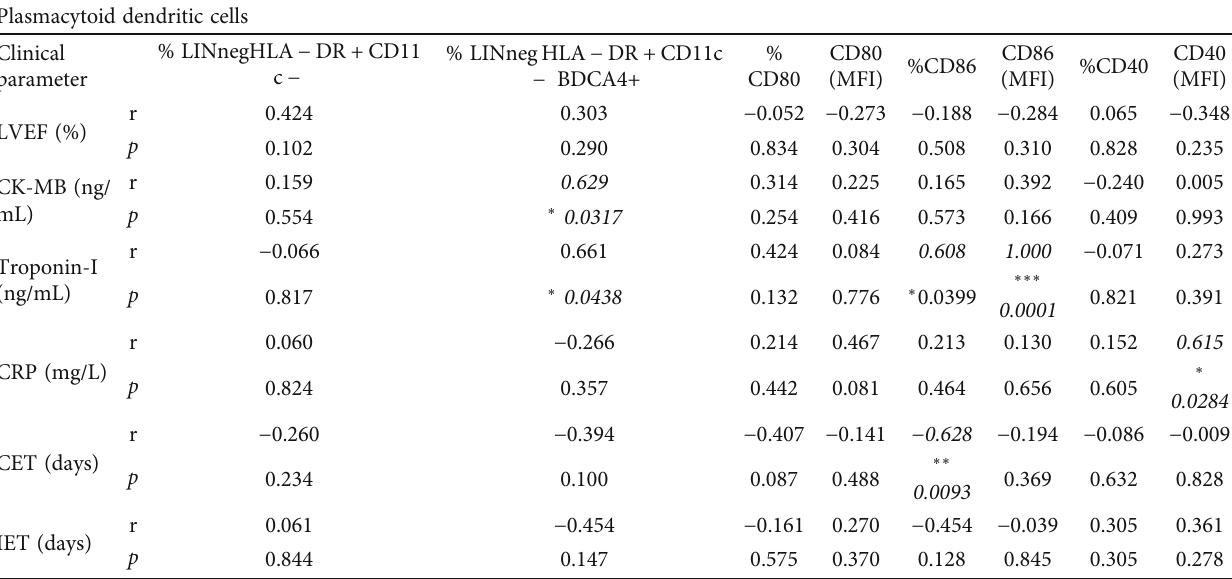
Table 3: Correlation between phenotypic characteristics of myeloid dendritic cells (mDCs) with di ff erent clinical parameters. Plasmacytoid dendritic cells